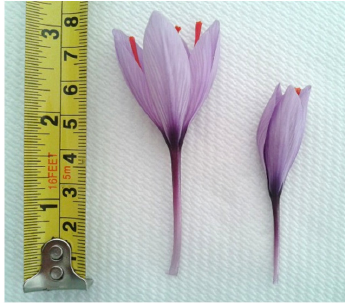
Figure 8. Flowers from corms from Holland were longer than flowers from Spanish corms.